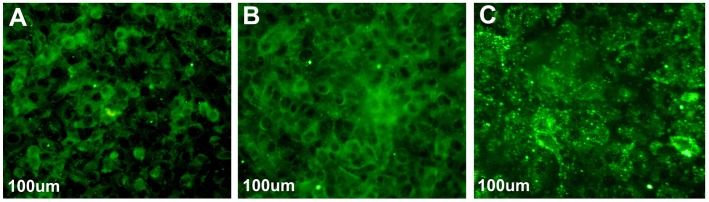
Immunofluorescence detection of tight junction correlated protein occludin in A549 cells.(A) DMSO control. (B) melatonin (0.1 mmol/L). (C) melatonin (2.0 mmol/L).